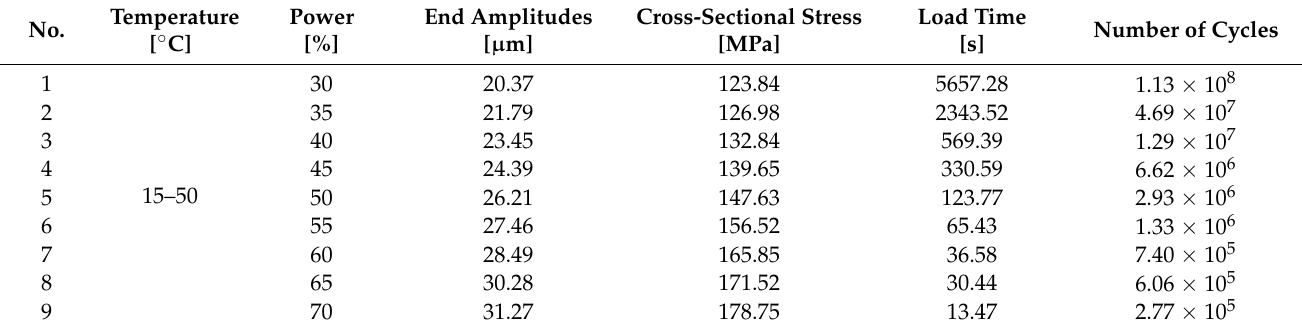
Table 5. Data from 20 kHz ultrasonic fatigue test on 6063-aluminum alloy.